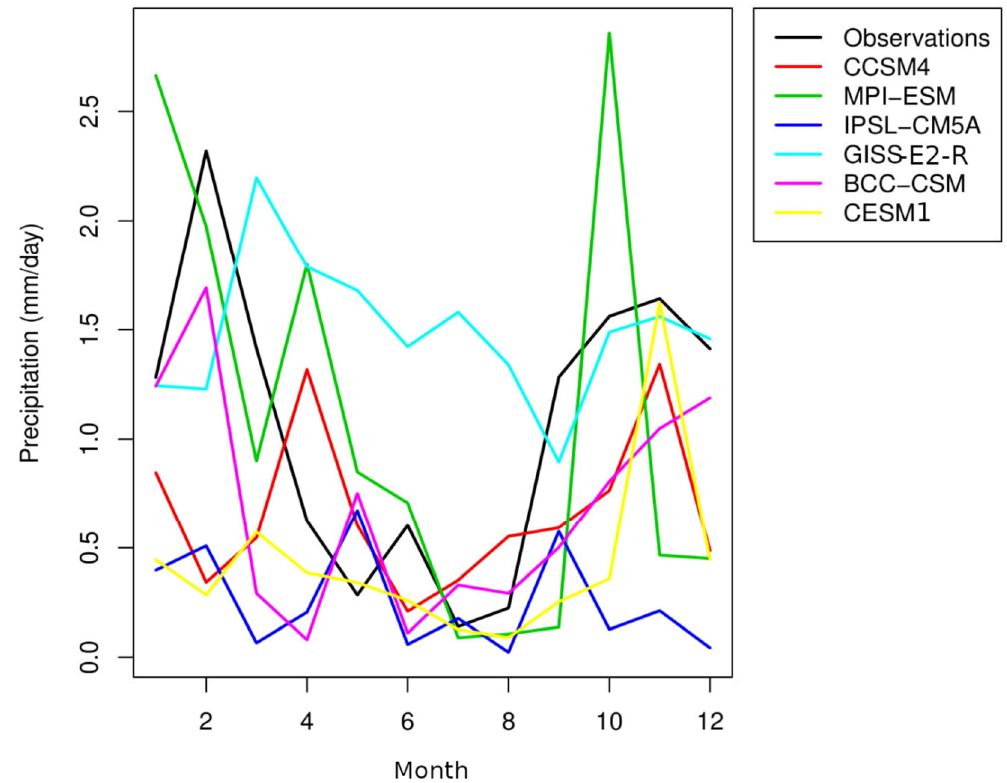
Figure 4. Seasonal climatological cycle of precipitation datasets: observations (Delaware) [43] and six Coupled Model Intercomparison Project (CMIP5) climate simulations over 1979–2005 in North Africa (between –5°W–5°E and 34°N–36.5°N).